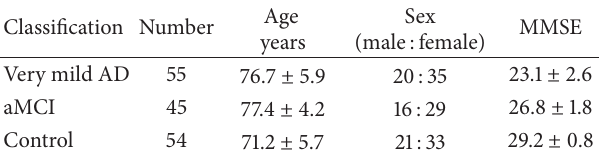
Table 1: Demographic data.